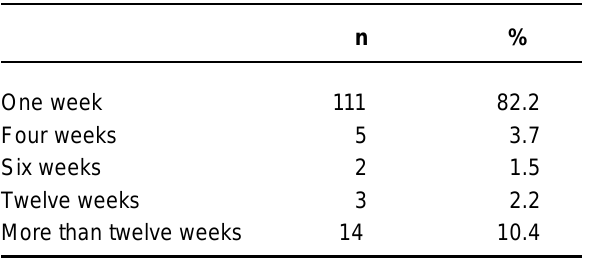
TABLE 7- Preferred time of use of sterilized, wrapped or packed instruments